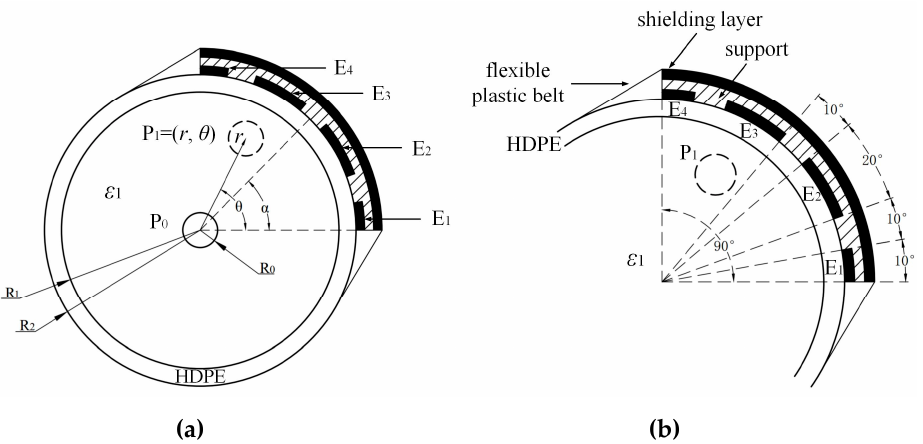
Figure 4. Capacitive sensor for the detection of the steel strand cross-section’s distribution. ( a ) Sensor placed on the external surface of duct and ( b ) sensor structure with 1/2 duct.